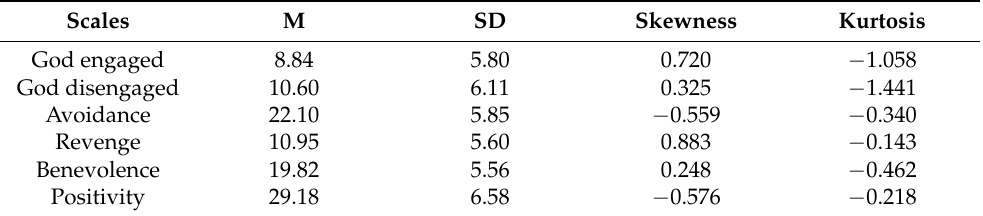
Table 1. Descriptive statistics for the Brief Measure of Perceived Divine Engagement and Disengage- ment in Response to Prayer (PDED), the Transgression-Related Interpersonal Motivations Inventory (TRIM-18), and the Positivity Scale (P Scale), (N = 464). Scales M SD Skewness Kurtosis God engaged 8.84 God disengaged Avoidance